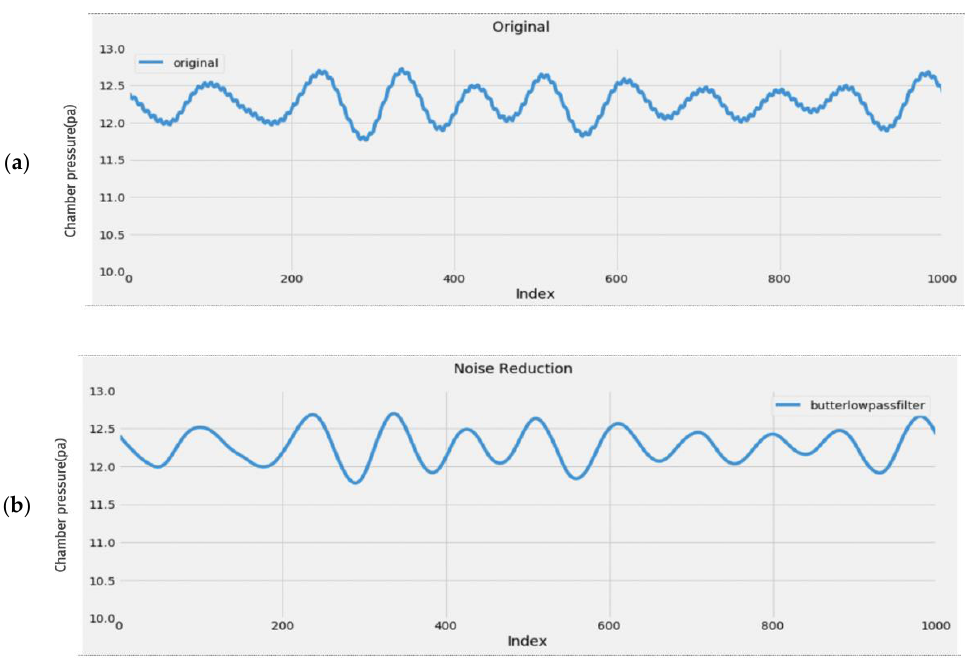
Figure 9. Air pressure signal of ( a ) before and ( b ) after noise reduction in OWC.